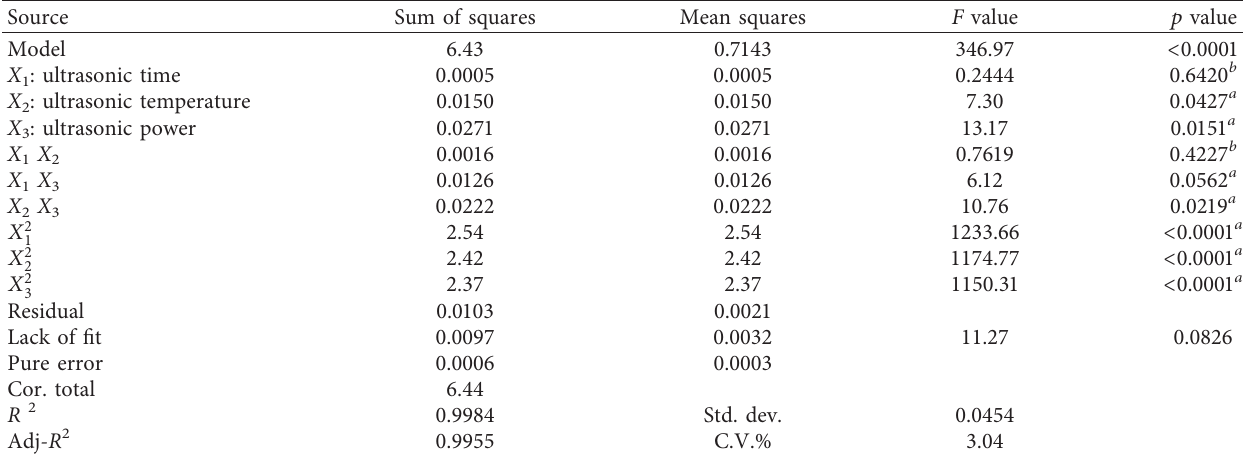
Table 3: ANOVA for quadratic model.